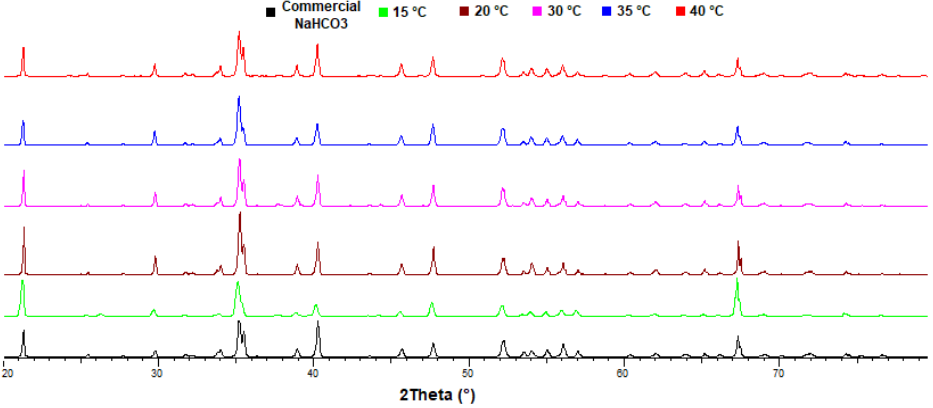
Figure 8. NaHCO 3 crystals—X-ray diffraction analysis.